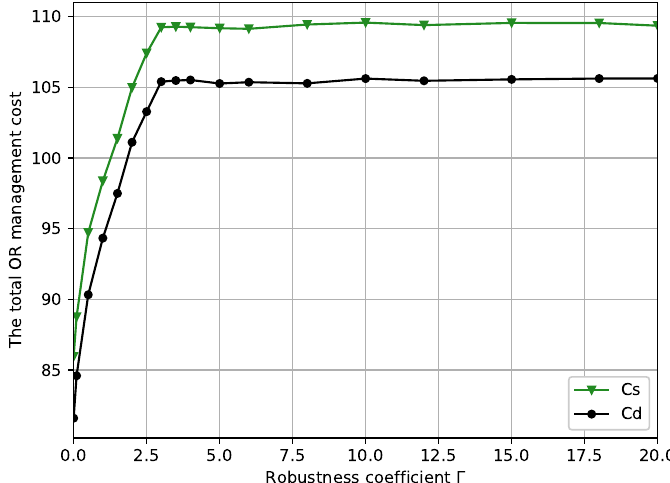
Figure 3. The minimum total OR management cost versus robustness coefficients, Γ